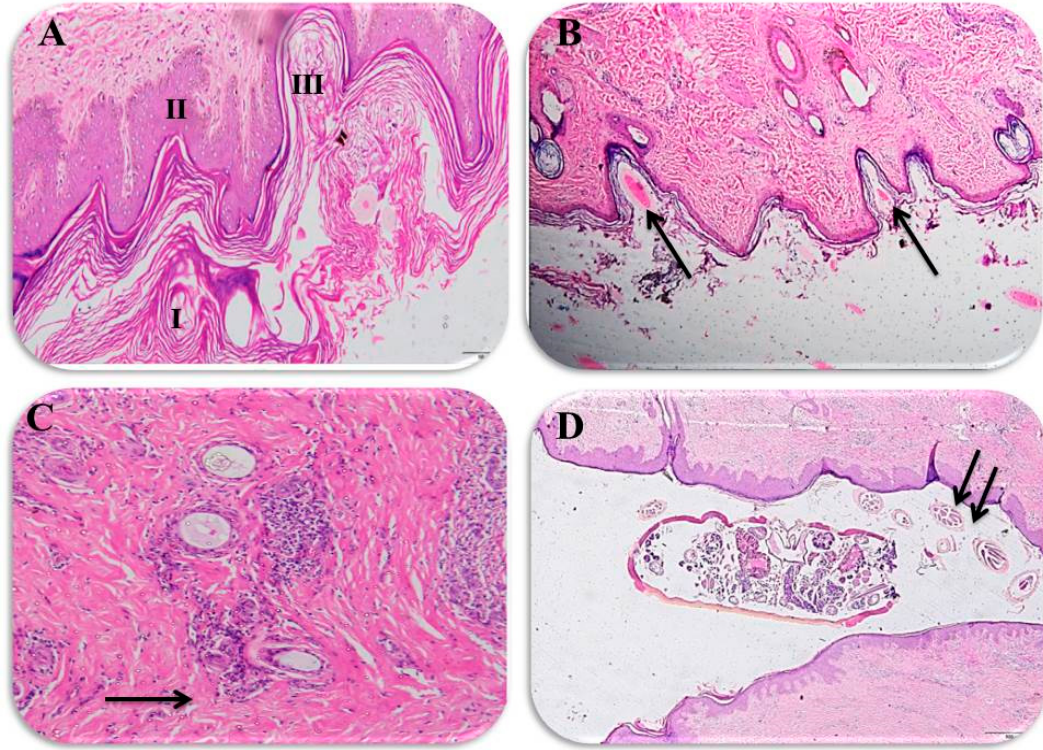
Figure 3. Histopathological findings for the infected camels: ( A ) the epidermis is thickened by compact hyperkeratosis (I) and acanthosis (II), which are in response to both the mite itself and also to the self-trauma caused by intense pruritus, and also shows the burrowing tunnels of the mites (III), ×100 magnification; ( B ) histological section showing Sarcoptic scabiei eggs in tunnels in the epidermis of an infested camel (arrow), ×200; ( C ) dermis showing inflammatory cell infiltration around the blood vessels and perifolliculitis (arrow), ×100; and ( D ) adult Sarcoptic scabiei and its eggs within the migrating tunnels of the camel skin (arrow), ×200.